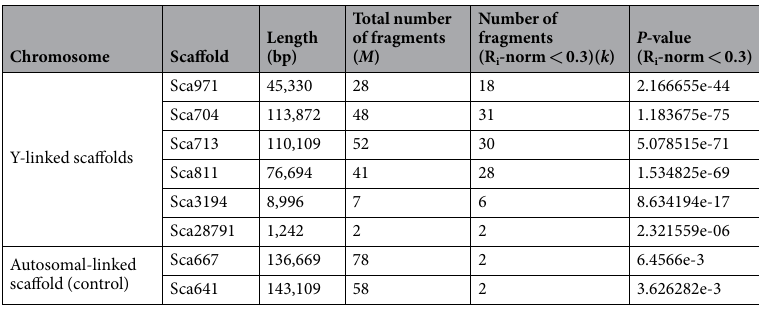
Table 2. Enrichment analysis of Y-linked scaffolds using hypergeometric test in R. Note: Number of total fragments in the genome reference ( N ) is 605,448; Number of total number of fragments (R i -norm < 0.3) in the genome reference ( n ) is 923. Putative autosome scaffolds are used as